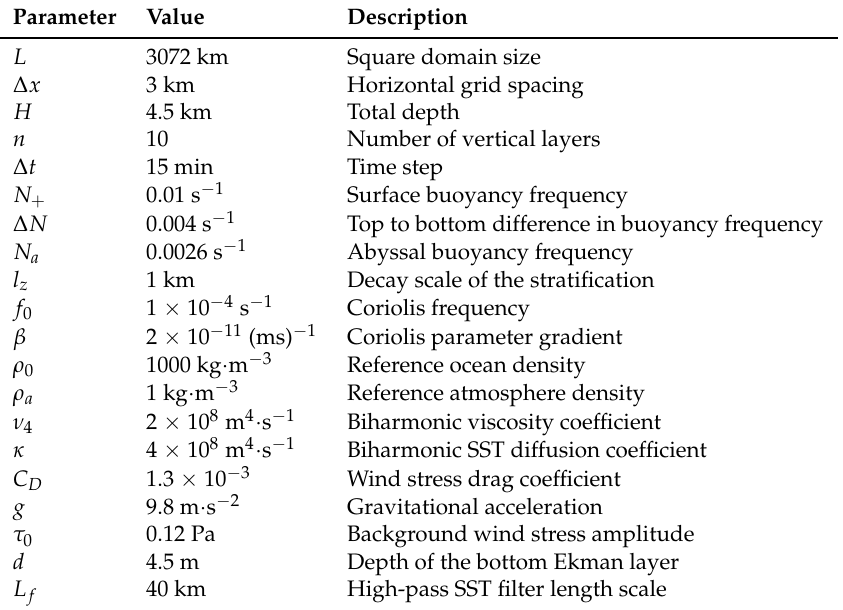
Table 1. Parameter values used in the simulations, and their descriptions.